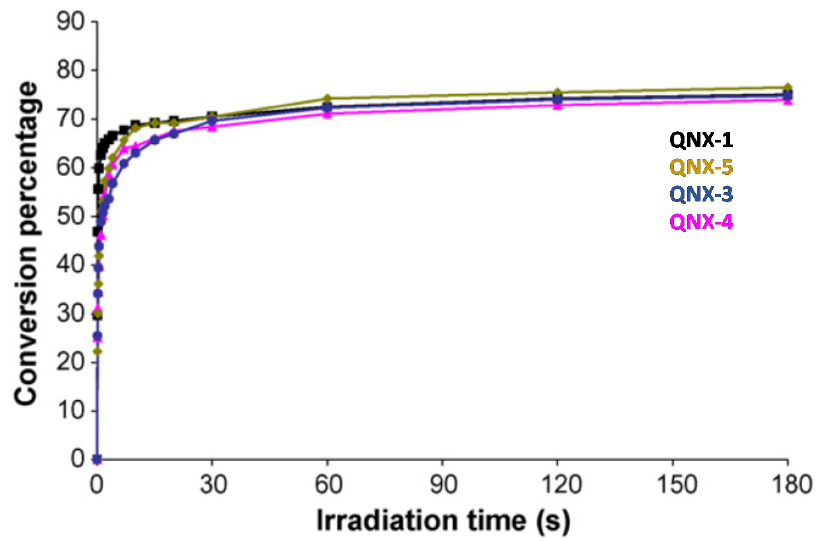
Figure 14. Polymerization profiles obtained during the FRP of an EA/TPGDA (3/1) blend under air and using the two-component dyes/MDEA (1%/10% w / w ), Reprinted from Ref. [224] Copyright 2007, Elsevier.